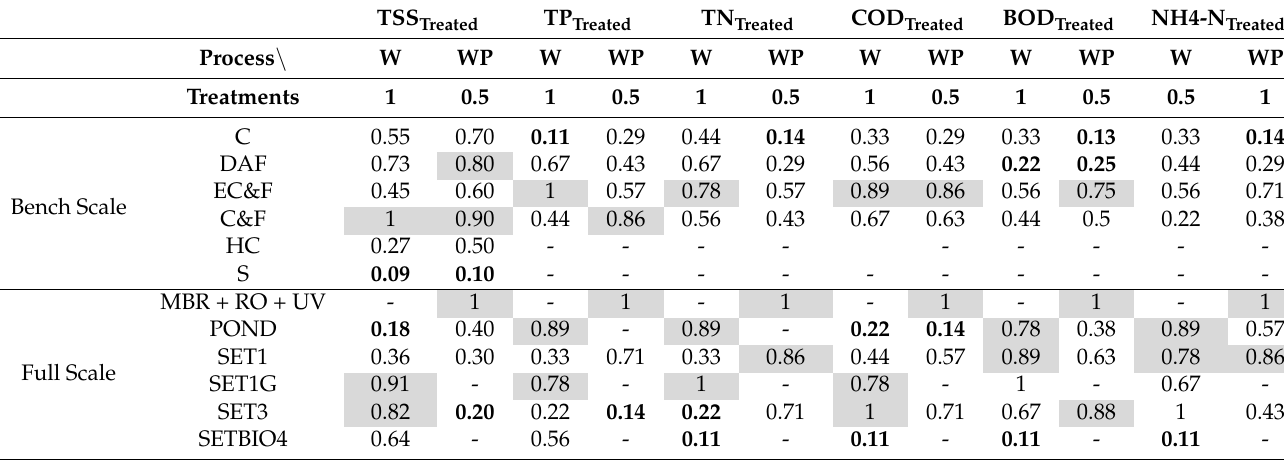
Table 1. The developed ranks represent the ability of treatment to be effective, ranked best (1) to worst (0). Ranks greater than 0.75 are bolded, and ranks lower than 0.25 are shaded, while the remainder are left blank, for visual aid. The ranking for process is also provided.